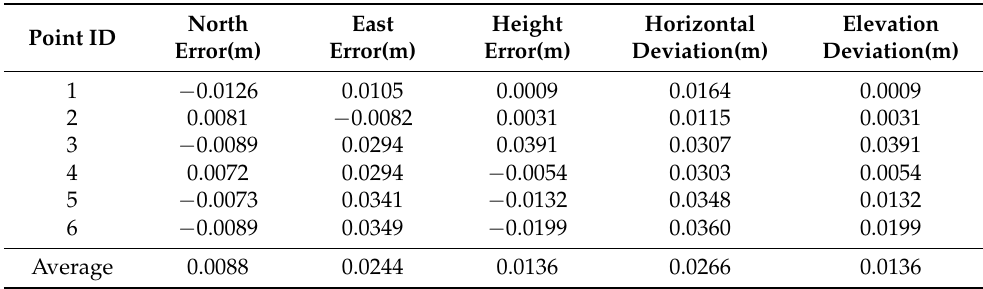
Table 6. Error of the same name point generated by multi-sensor fusion and point cloud generated by integrated